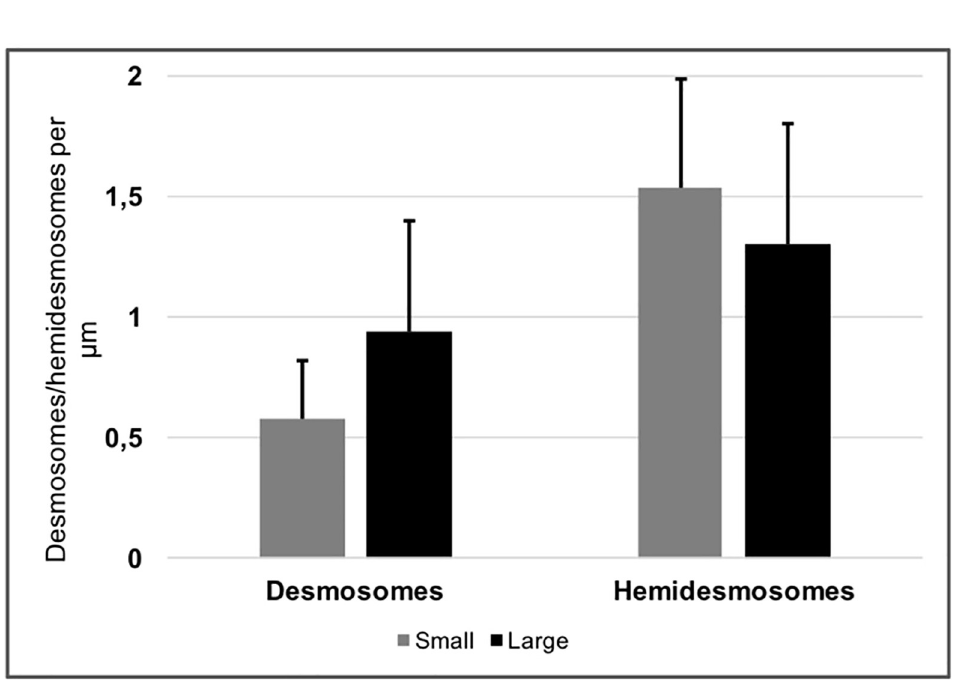
Fig 6. Quantification of desmosome and hemidesmosome density. Bar chart showing the number of desmosomes (black) and hemidesmosomes (grey) per μ m in human LEC derived from small and large explants. There were no significant differences between the groups. Error bars represent the standard deviation of mean